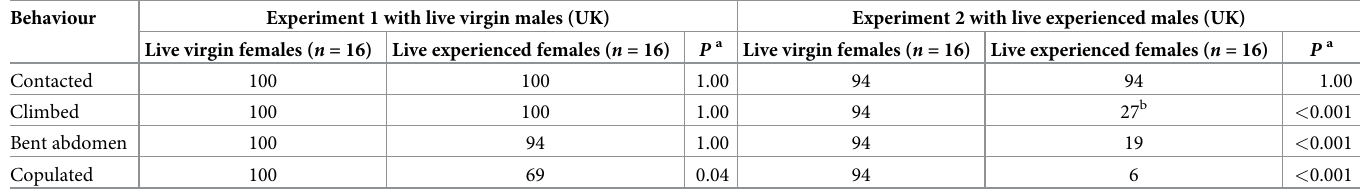
Copulated 100 69 0.04 94 6 < 0.001 ‘Experienced males’ and ‘experienced females’ had been exposed to high densities of males and females.